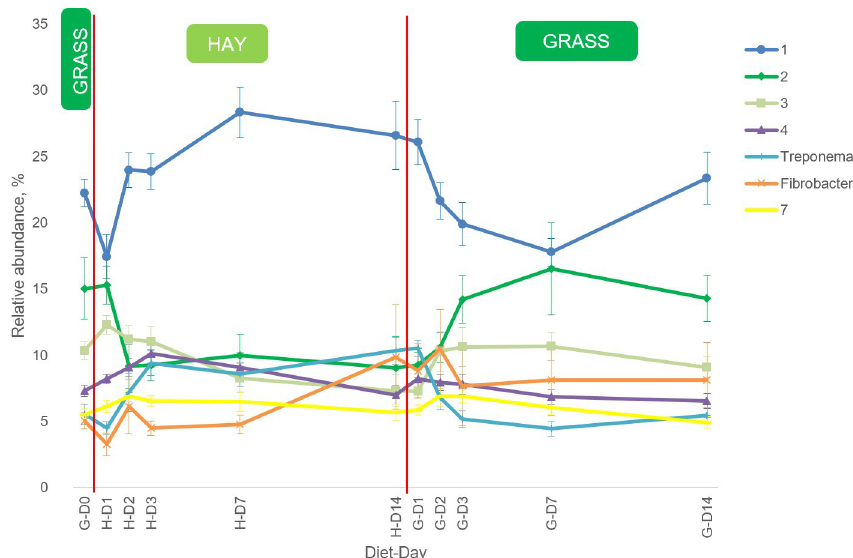
Fig 6. Bacterial genera dynamics in the faeces of the ponies (n = 6) during the abrupt transitions. Bacterial genera with average relative abundance (RA) > 5% are presented. Error bars represent standard error of the mean. Red vertical lines represent abrupt changes in the diet. Unassigned genera were numbered in descending order based on their RA. D: day; H: hay; G: grass. All genera were traced back to their correspondent phylum > class > order >